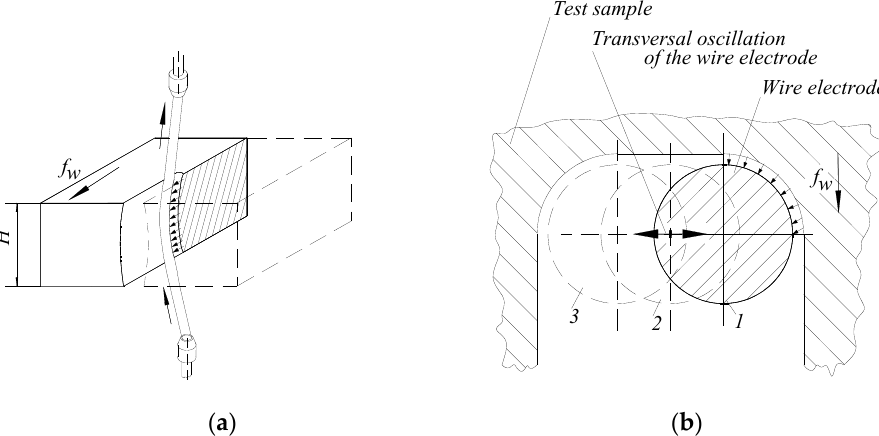
Figure 3. Lag of the wire electrode in the middle area of the test sample ( a ) and a cross-section through the middle area of a test sample to observe the oscillation of the wire electrode in a plane perpendicular to the direction of entry of the wire electrode in the test sample, in the middle area of the test sample ( b ): 1—position of the electrode wire at the end of the oscillation to the right; 2—the central position of the wire electrode; 3—wire electrode position at the end of the oscillation to the left.